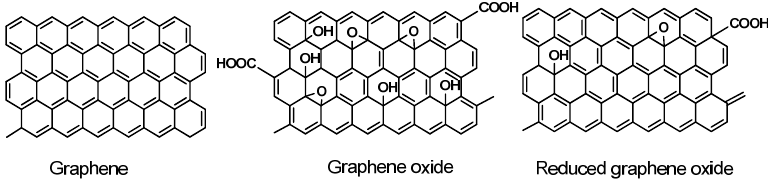
Figure 1. Idealized structures of graphene, graphene oxide (GO) and reduced graphene oxide (rGO).